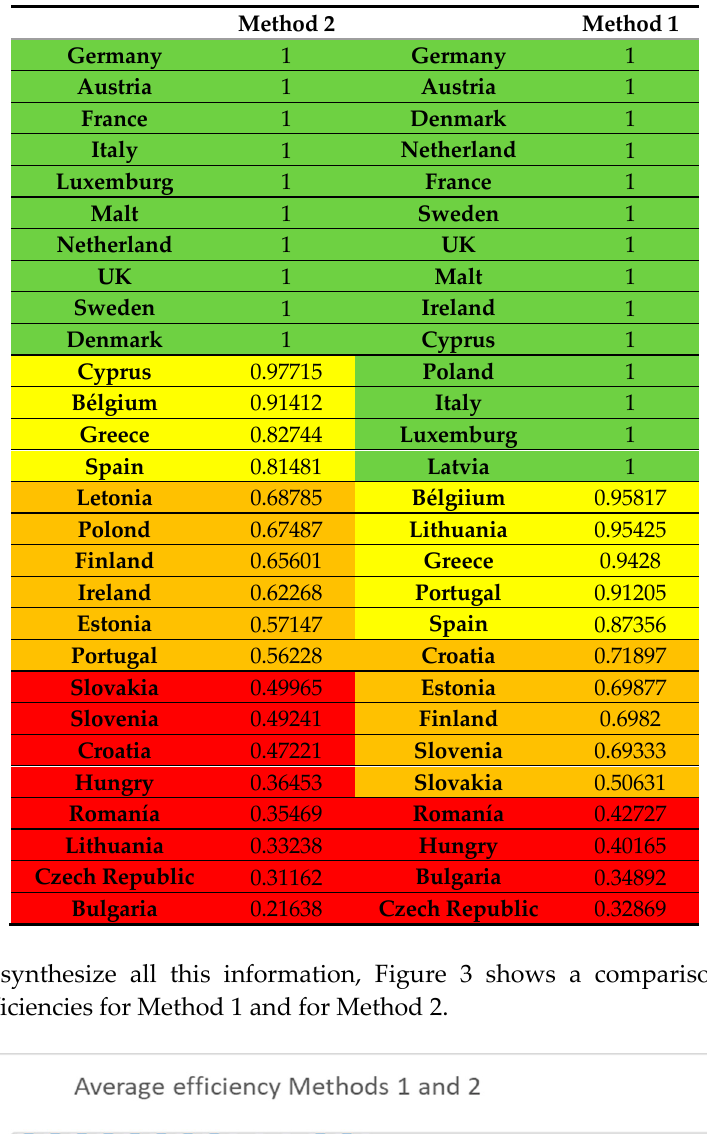
Table 10. Classification into categories based on average environmental efficiency with Methods 1 and 2 for the 28 countries in the period 2005–2012. Source: self made.